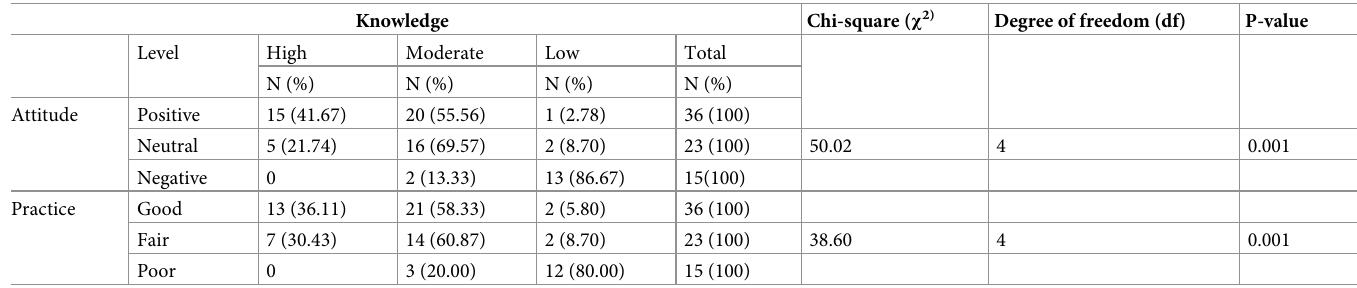
Table 9. Association between KAPs of the farmer on the factors contributing to the occurrence of AMR in dairy cows and